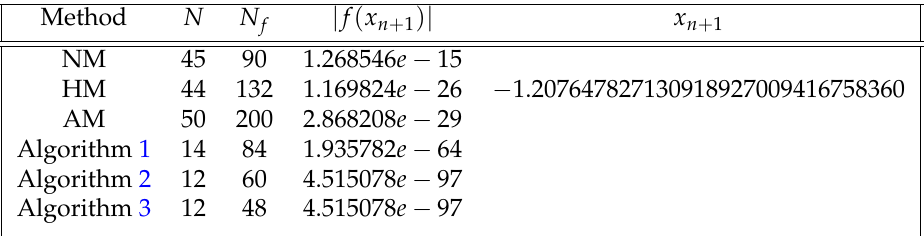
Table 5. Comparison of NM, HM, AM and Algorithms (1), (2) and (3) .